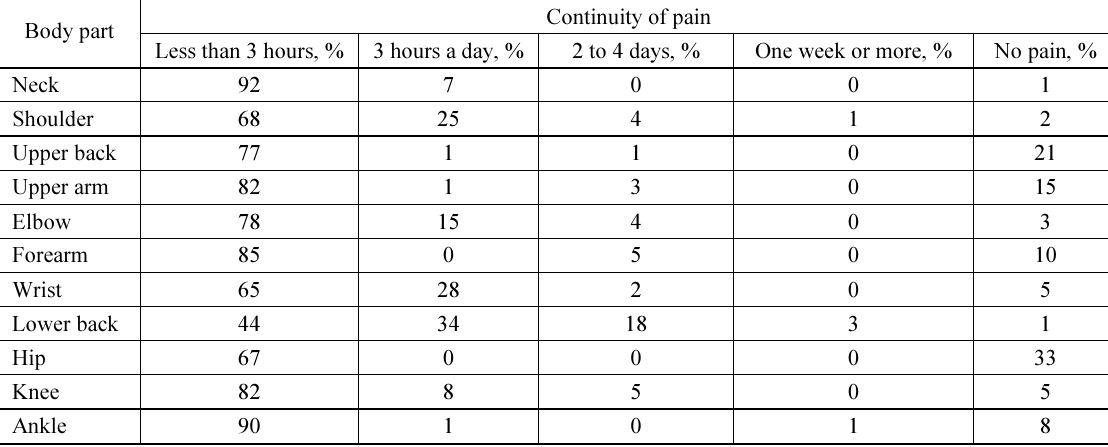
Continuity of pain